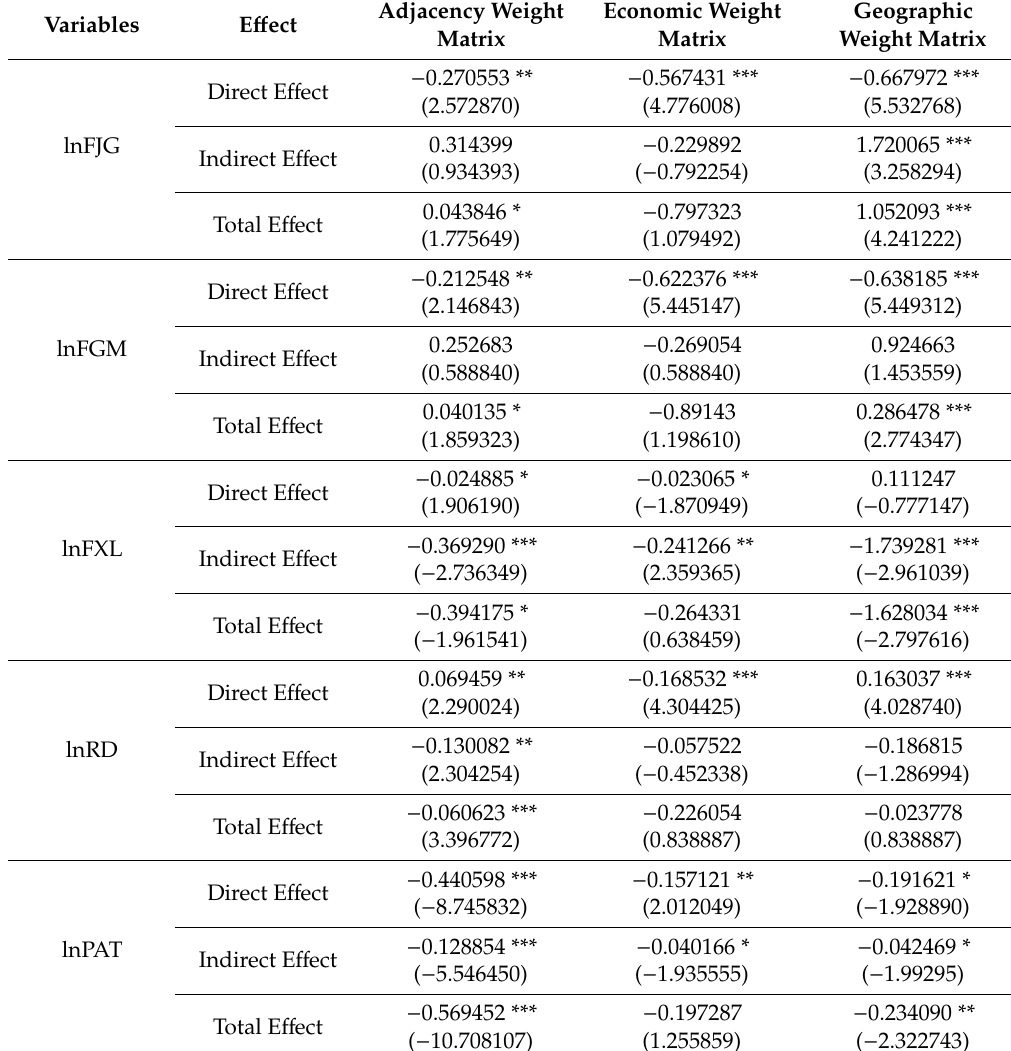
Table 4. Direct e ff ect, indirect e ff ect, and total e ff ect of the spatial Durbin model.